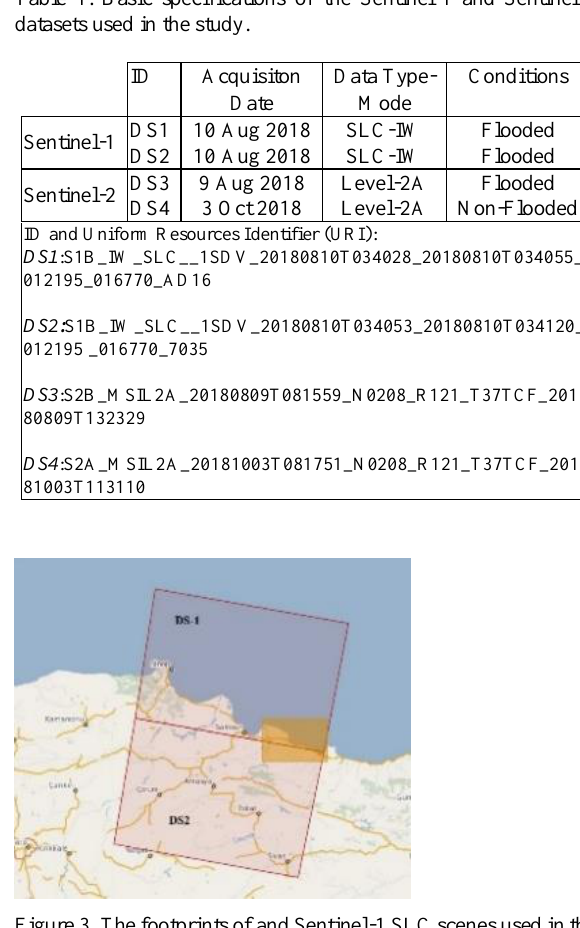
Figure 3. The footprints of and Sentinel-1 SLC scenes used in the study.